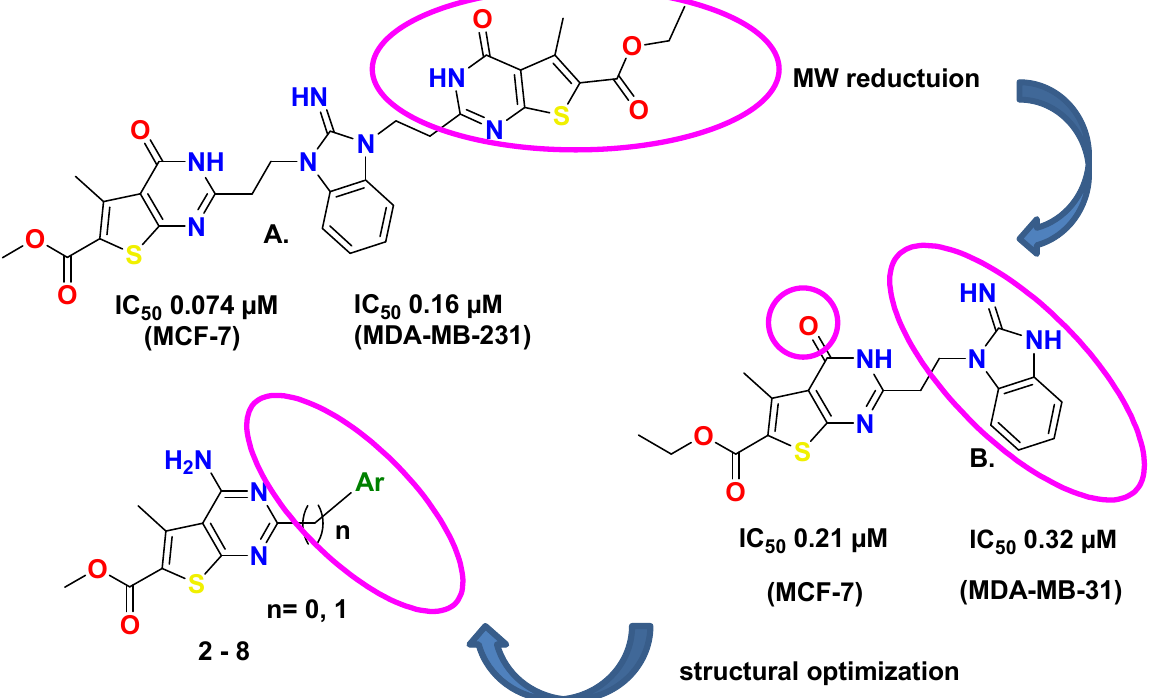
Figure 2. Structural optimization of compound A and B, MW (Molecular weight).